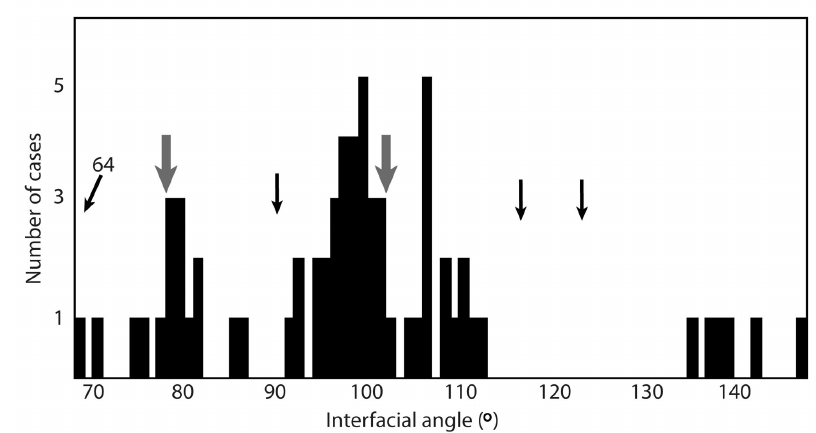
Fig. 3. Interfacial angles of tablet imprints in the inner shell layer of Mackinnonia davidi from the early Cambrian of South Australia. Expected interfacial angles for rhombic calcitic nacre are indicated by thick grey arrows, expected angles for nacre are indicated by thin black